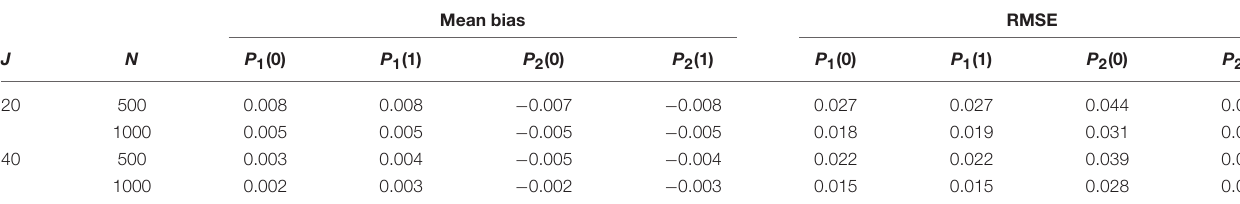
TABLE 3 | Recovery of item estimates with the GPDM.